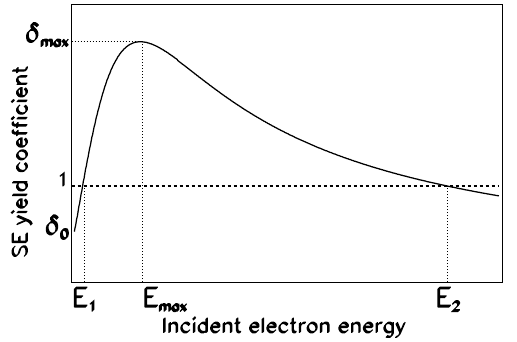
FIG. 7. Universal secondary electron yield coefficient curve (cid:3) (cid:2) E (cid:3) , where E is the incident electron energy. The maximum for an incident energy E . The value value of (cid:3) occurs at (cid:3) max max < E < E , and (cid:3) is of (cid:3) is greater than unity in the range E 1 2 0 the finite probability that very low-energy electrons are re- flected. The curve depends on the surface material, surface (cid:4) conditioning, and incident angle. Typical values are (cid:3) max (cid:4) 0 : 5 , E (cid:4) 300 eV , E (cid:4) 50 eV , and E (cid:4) 1 keV 1 – 3 , (cid:3) 0 max 1 2